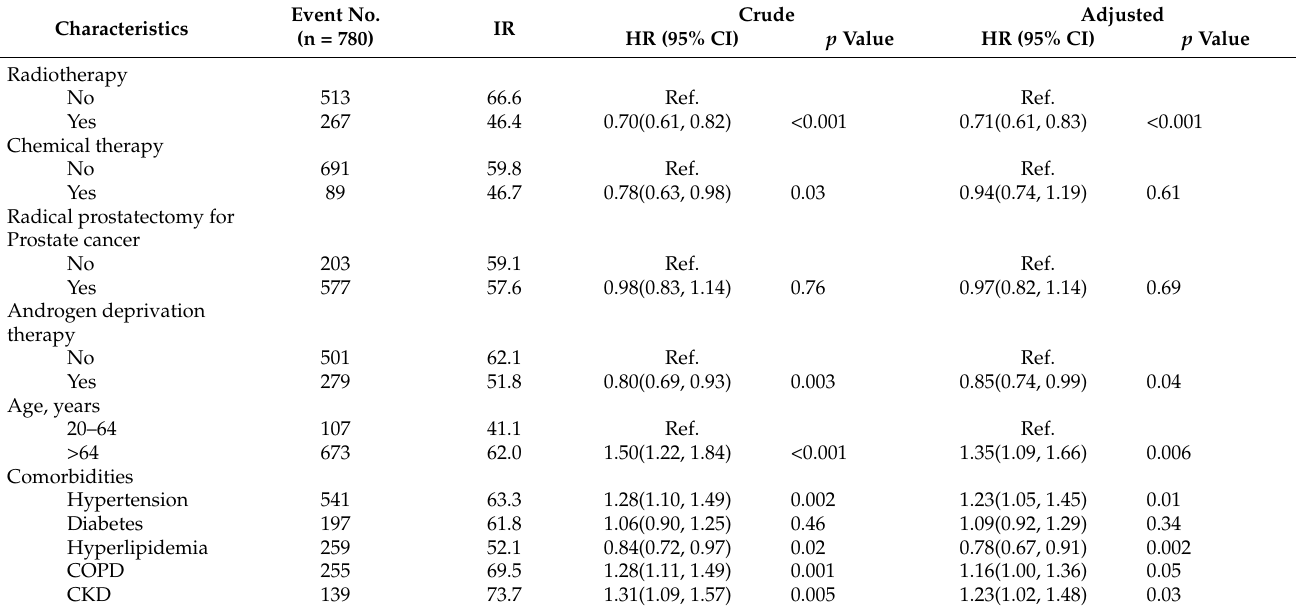
Table 5. The associations between urinary tract infections and different treatments and covariates in the patients with prostate